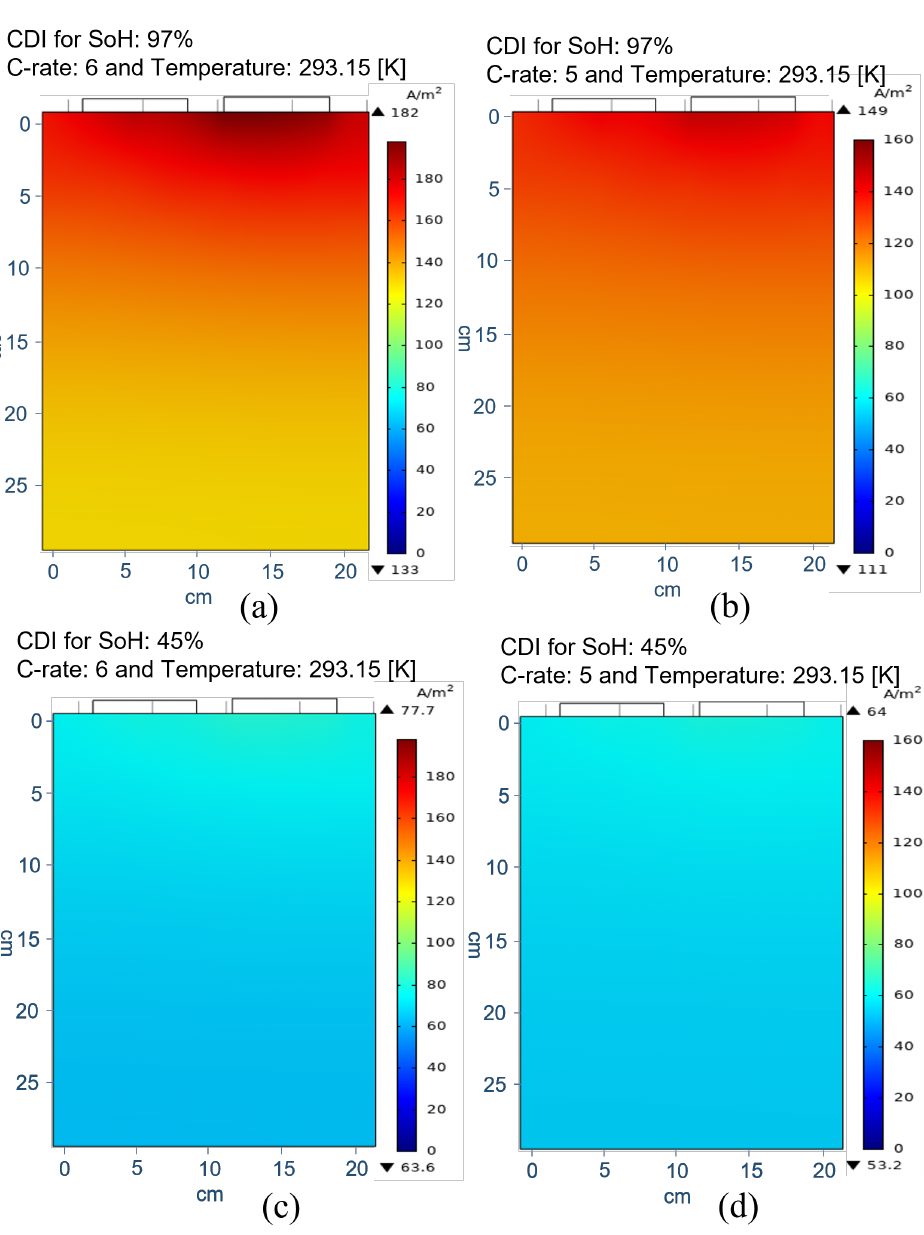
Figure 7. CDIs from the positive electrode at room temperature (293.15 [K]). ( a , b ) A fresh cell was charged with C-rates of 6C and 5C, respectively. ( c , d ) An aged cell was charged with C-rates of 6C and 5C,